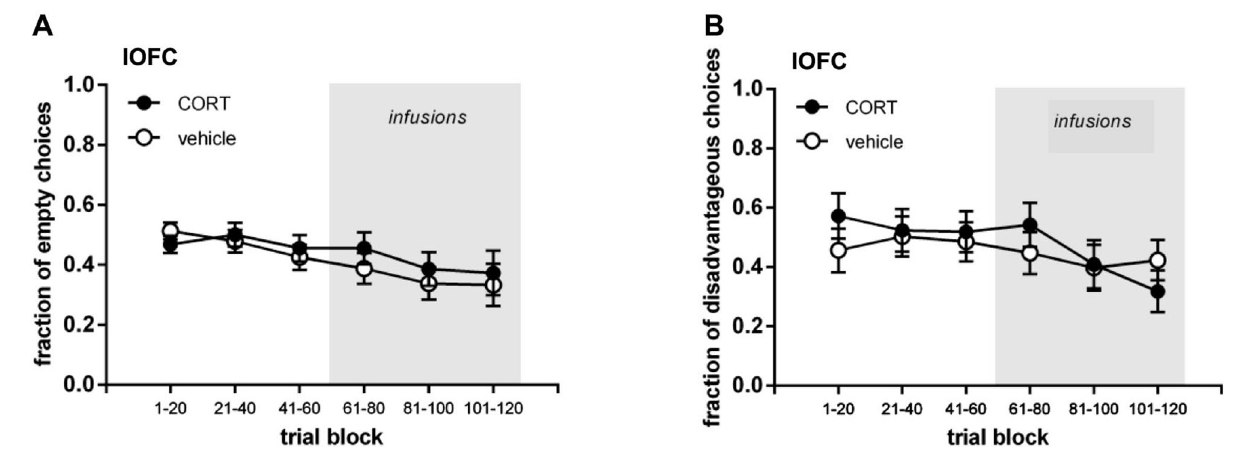
FIGURE 3 | Lateral orbitofrontal cortex (lOFC) cannulated groups. (A) Mean ( ± SEM) fraction of visits to empty arms. (B) Mean ( ± SEM) fraction of visits to disadvantageous